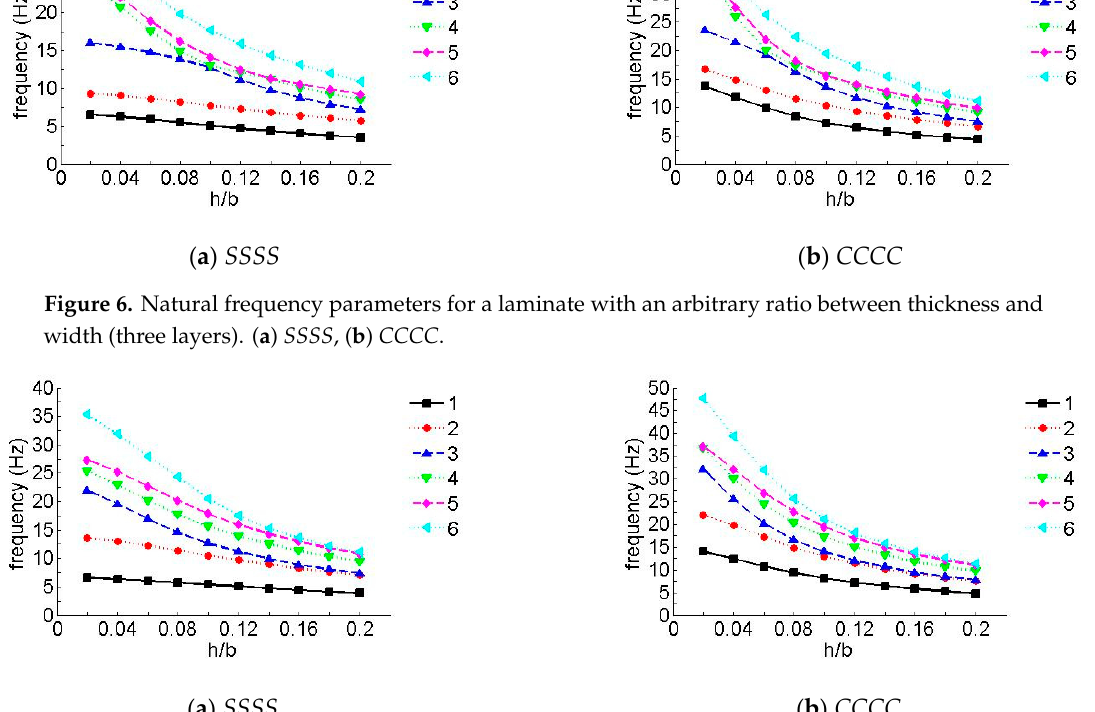
Figure 7. Natural frequency parameters for a laminate with an arbitrary ratio between thickness and width (five layers). ( a ) SSSS , ( b ) CCCC